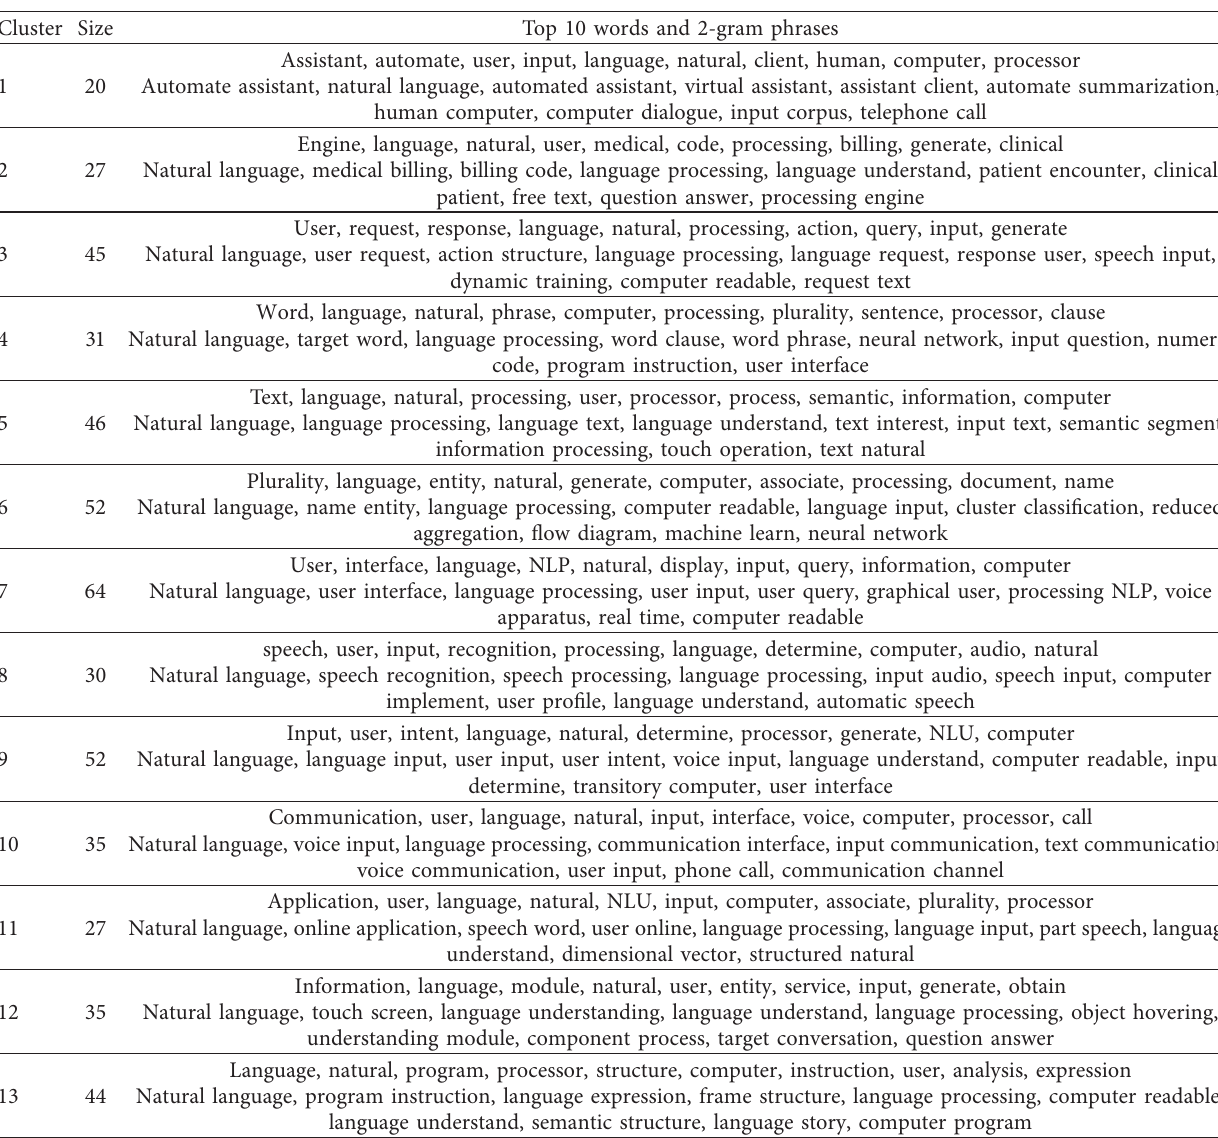
Table 3: Top 10 words and 2-gram phrases in each cluster. Top 10 words and 2-gram